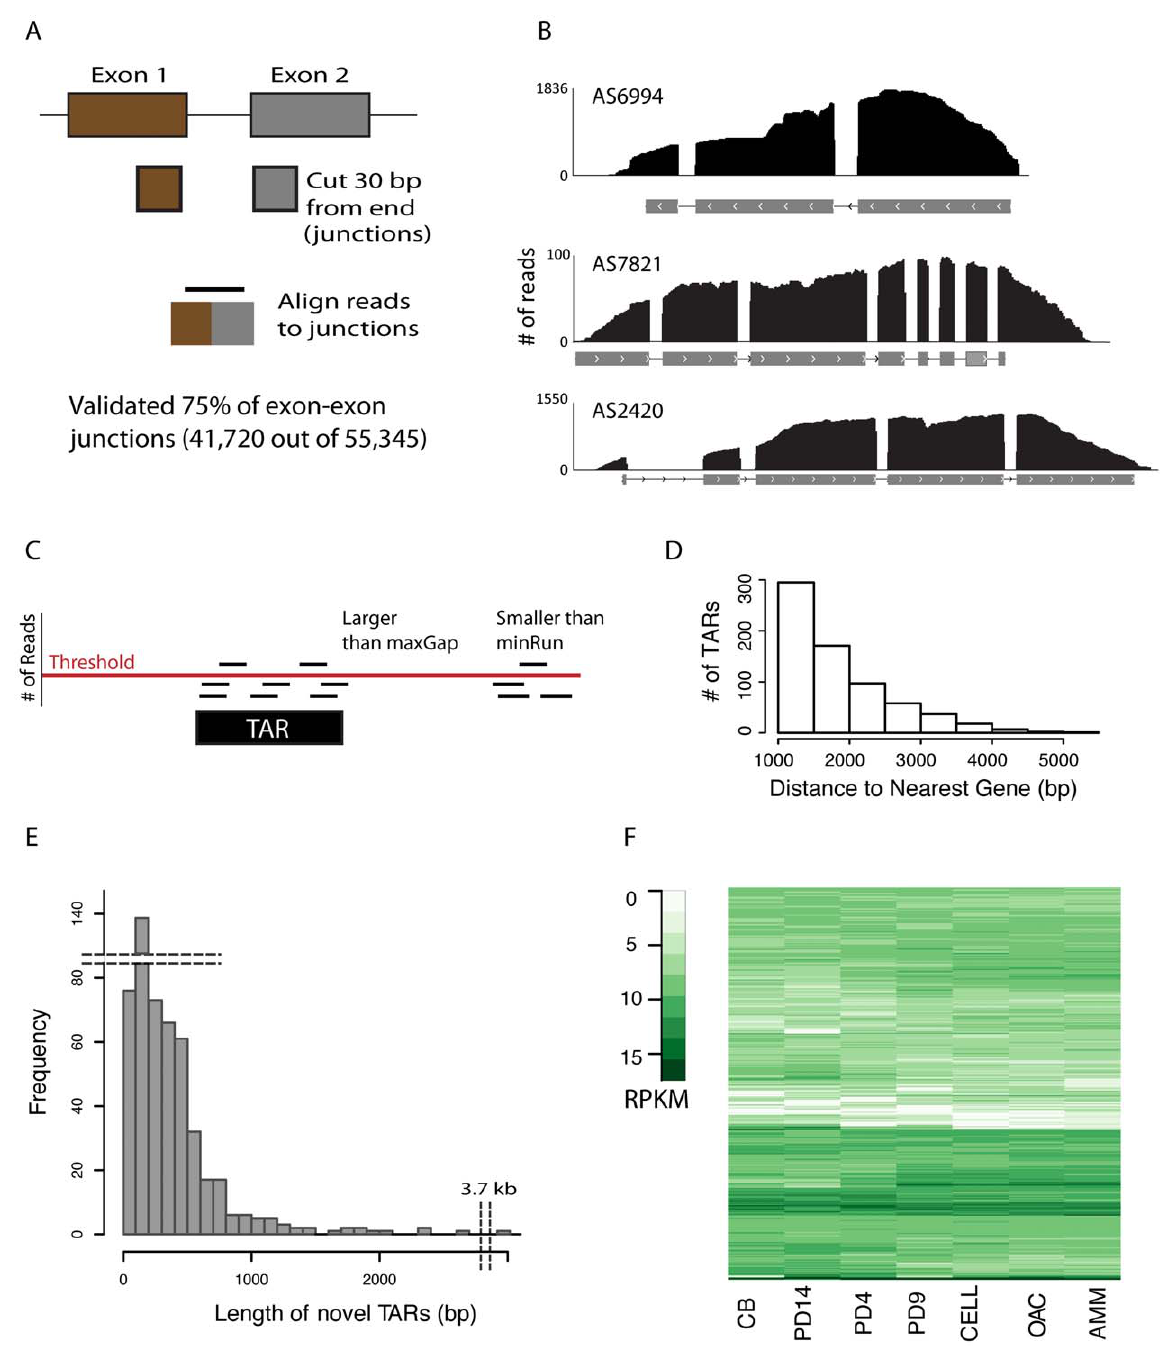
Figure 1. Validating gene models and novel TARs. (A) Schematic showing splice junction library generation. (B) For each of the three gene models shown, the x-axis is the genomic coordinates and the gray boxes represent individual exons, with arrows indicating strand. Reads having any overlap with the genic region are represented by black lines, the height of which correspond to the number of reads covering a particular base pair. Note that a read can align outside the exonic region, but that this was not observed at intron boundaries, although it did occur in the UTRs. (C) Schematic illustrating de novo assembly of reads into transcriptionally active regions (TARs). Three parameters are shown: threshold, min run, and max gap. Threshold sets the number of reads required for the region to be considered in the assembly. minRun sets the number of base pairs in the contiguous region required, and maxGap sets the number of discontiguous base pairs permitted to still be considered part of the assembly. Only the black box has sufficient base pairs above the threshold with the permitted contiguous length to be considered a TAR. (D) The minimum distance between each TAR and its nearest neighboring gene was computed. The number of TARs at least 1 kb away from any gene are shown (novel TARs). (E) Histogram of the length of novel TARs. Note the break in both the x and y-axis to indicate the outliers for TAR length and frequency. (F) Columns represent the culture growth conditions, rows individual novel TARs, and elements are color coded according to their RPKM value from white (no expression) to dark green (high expression).